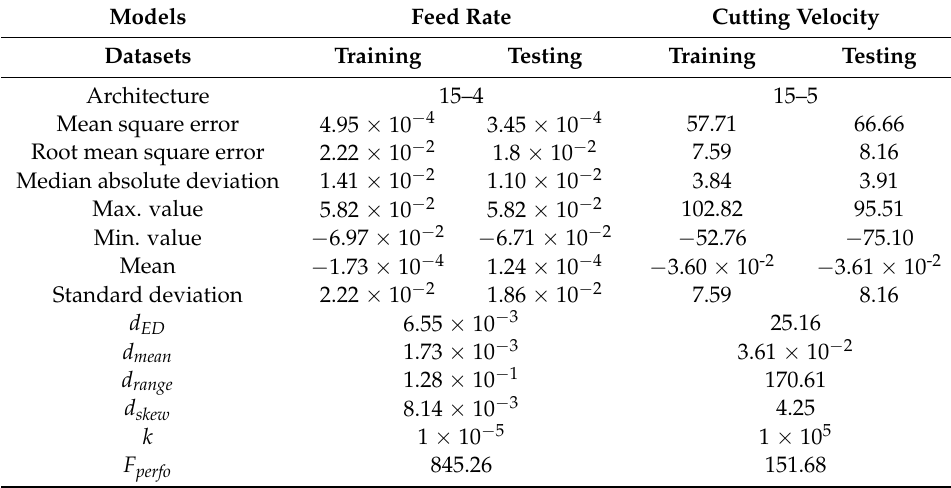
Table 4. Error validation for feed rate and cutting velocity